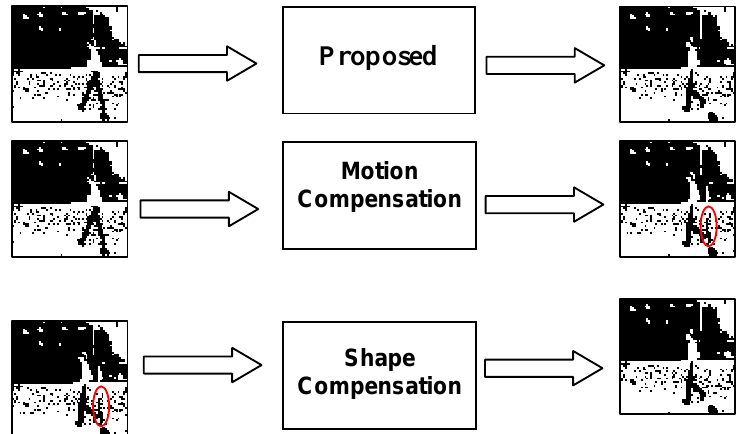
Figure 1. A schematic diagram to present the idea of shape compensation.